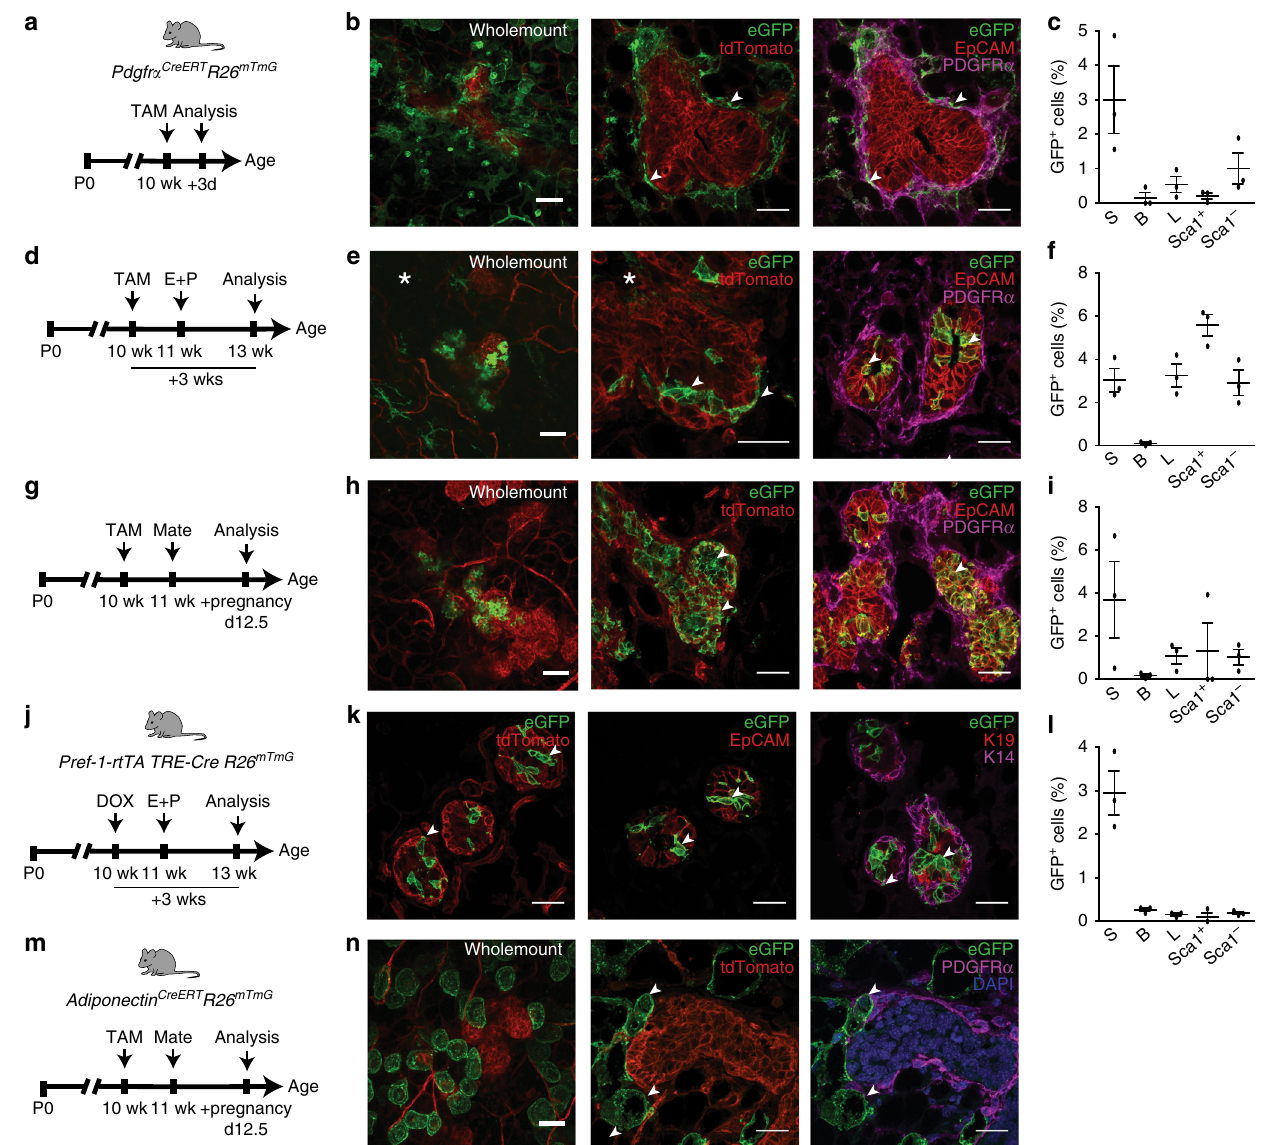
Fig. 4 Mesenchymal adipocyte progenitors are recruited into the adult mammary epithelium during cellular expansion. a Short trace regimen in the tamoxifen (TAM)-inducible Pdgfr α CreERT R26mTmG model. b Wholemount (left) and tissue sections immunostained for GFP (green), tdTomato (red) (middle) and GFP with EpCAM (red), PDGFR α (magenta) (right) isolated from an adult gland 3 days following TAM injection. c Flow cytometry quanti fi cation of GFP + cells within stromal (S), basal (B), luminal (L), and luminal Sca1 + , Sca1 - subsets in the 3d short trace ( n = 3 mice). d Three week trace of PDGFR α + cell progeny after TAM induction and hormone stimulation. e Native fl uorescence within lobuloalveoli after E + P treatment (left) and GFP + cells in tissue sections (middle, right). f GFP + cells in mammary subsets after a 3 week trace ( n = 3 mice). g PDGFR α + cell tracing during pregnancy. h Wholemount fl uorescence showing GFP + lobuloalveolar structures during mid-pregnancy (left) and immunostaining on tissue sections (middle, right). i GFP + cell proportions during pregnancy ( n = 3 mice). j Lineage tracing Pref-1 + mesenchymal adipocyte progenitors in the Pref-1-rtTA TRE-Cre R26mTmG model following DOX induction and hormone stimulation. k Mammary tissue sections from Pref-1 tracing mice co-stained for eGFP (green) and tdTomato (red) (left), eGFP with epithelial markers EpCAM (red) (middle) and K19 (red), K14 (magenta) (right). l GFP + cell distribution in mammary subsets of Pref- 1 adult mice stimulated with hormones ( n = 3 mice). m Mature adipocyte lineage tracing model subjected to TAM induction and pregnancy. n Mammary tissue isolated from adipocyte tracing mice analyzed by wholemount (left) and immunostaining (middle, right) with eGFP (green), tdTomato (red), PDGFR α + (magenta) and DAPI (blue), showing an absence of mature adipocyte recruitment into the epithelium ( n = 3 mice). Scale bar = 50 µ m for wholemounts and 25 µ m for tissue sections; arrowheads indicate GFP + cells. Images are representative of 5 fi elds per tissue section per mouse. White asterisk denotes associated Supplementary Movies 2 and 3. Data represent mean ± s.e.m. Source data are provided as a Source Data fi